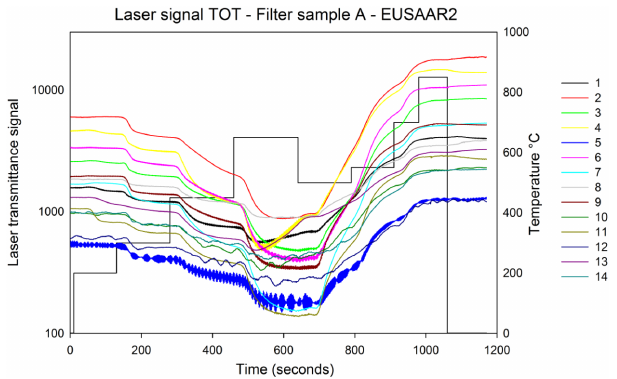
Figure 11. Laser transmittance signal during filter sample G analy- sis with the use of EUSAAR2 thermal protocol for all